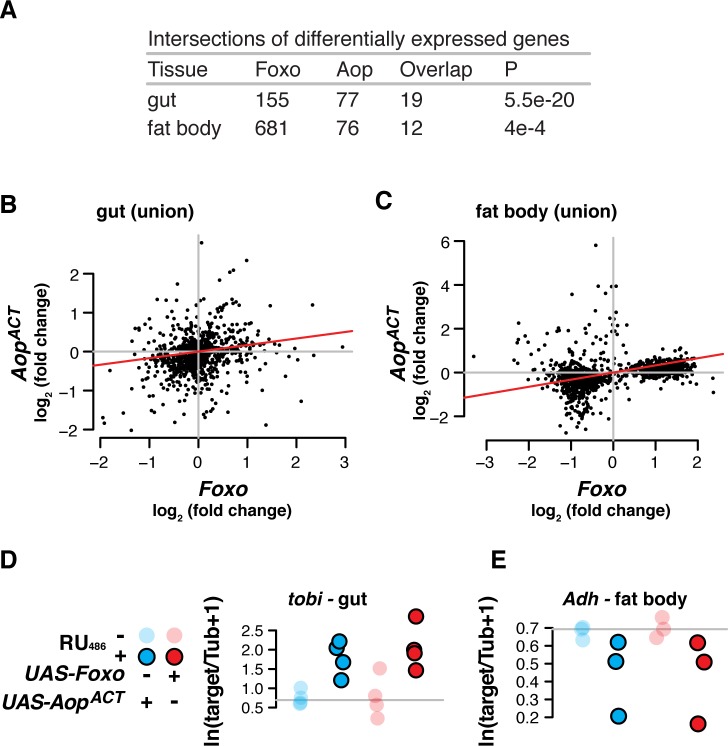
Aop recapitulates Foxo’s transcriptional output.(A) Transcriptomic analysis reveals that overexpression of either Foxo or AopACT under control of S106 induces differential expression of an overlapping set of genes, in both gut and fat body. P values from hypergeometric tests. (B-C) In both gut and fat body, in the unions of sets of differentially expressed genes, transcriptomic effects of AopACT correlate those of Foxo (log2 fold-change expression, calculated by DESeq2). Red lines show correlation coefficients (Kendall’s Tau, p<10e-14 for both tissues). (D-E) qRT-PCR confirms congruent effects of AopACT and Foxo in fat body and gut (linear model: RU486 p<0.05 for either target, no effect of TF).